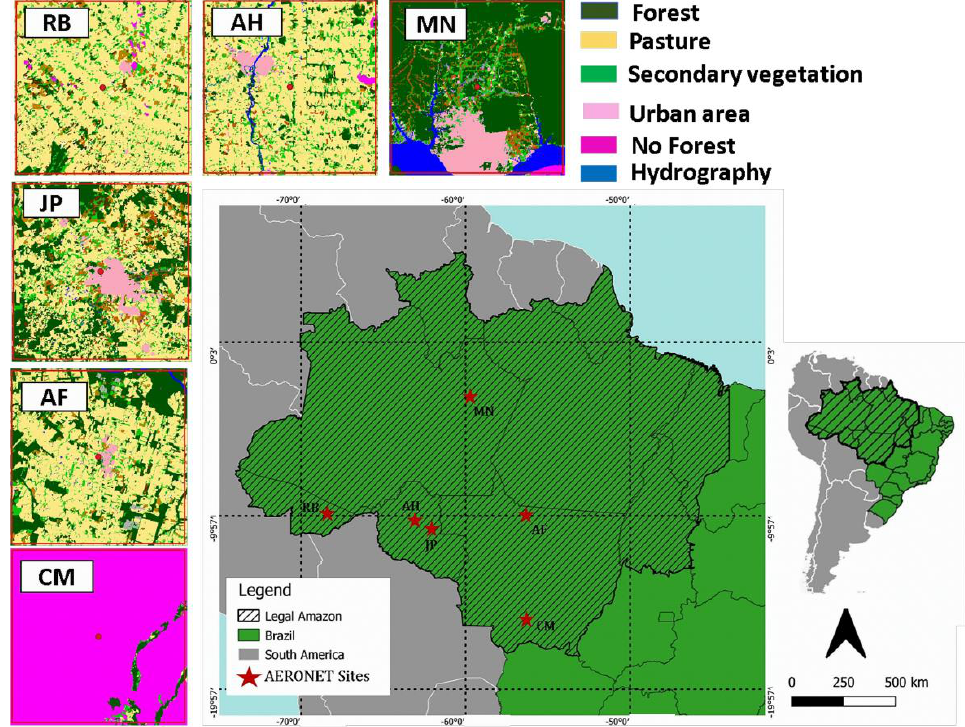
Figure 1. Site locations considered in this study. The red stars represent AERONET sites and the dashed area is the Legal Amazon. The acronyms represent the sites, where AH is Abracos Hill, AF is Alta Floresta, RB is Rio Branco, JP is Ji Parana, MN is Manaus, and CM is Cuiabá Miranda. The figure also shows the 50 km × 50 km clippings from which the MODIS 3 km and 10 km estimates were extracted on each site, as well as the land use in these regions.